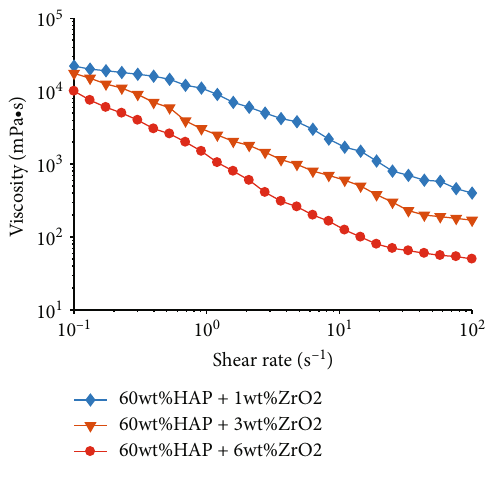
Figure 2: Rheological test